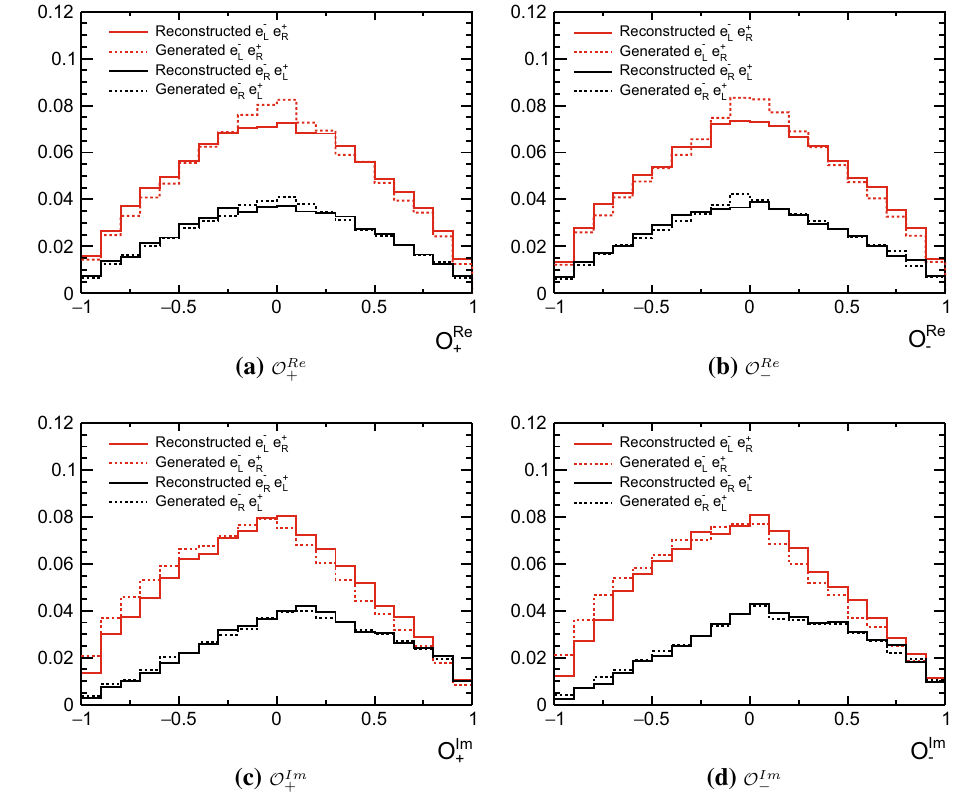
√ Fig. 3 The CP-odd observables O Re , Im ± for the ILC at s = 500 GeV. and − 30% positron polarization. The histogram for the left-handed The four distributions correspond to the reconstructed (solid) and true electron beam is normalized to unit area. The area of the histogram for (dashed) distributions for two beam polarizations. The red histogram right-handed polarization is scaled so as to maintain the cross section e + ( e − ) corresponds to − 80% electron polarization and + 30% positron ratios L R e + polarization, theblack histogram ( e − ) to + 80% electron polarization R L Table 5 Reconstructed values of the CP-odd asymmetries from a Monte Carlo simulation of the ILD detector response to t ¯ t events pro- √ s = 500 GeV. The quoted duced in electron–positron collisions at uncertainties are due to the limited statisitcs of the simulated samples